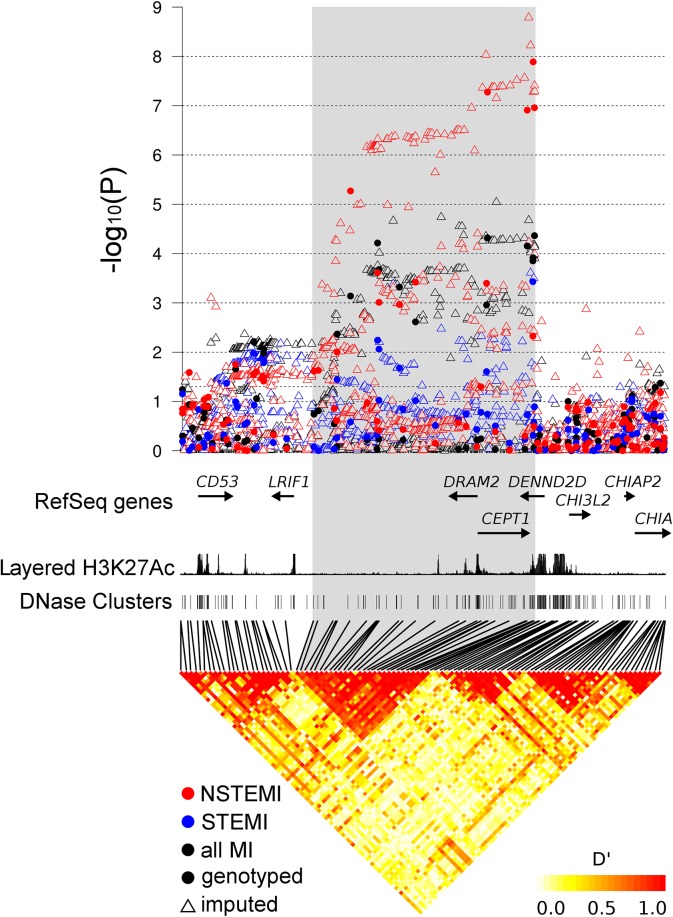
Association of genetic variants with the MI phenotypes and the LD structure at 1p13.3 (GRCh37 Chromosome 1:111,397,480–111,863,701).The P-values for both imputed and genotyped variants are depicted, while the LD is calculated from the genotyped SNPs only. Known genes from the RefSeq database are shown together with potential regulatory regions marked by histone 3 lysine 27 acetylation (Layered H3K27Ac) and DNase I hypersensitivity clusters from the Encode consortium.